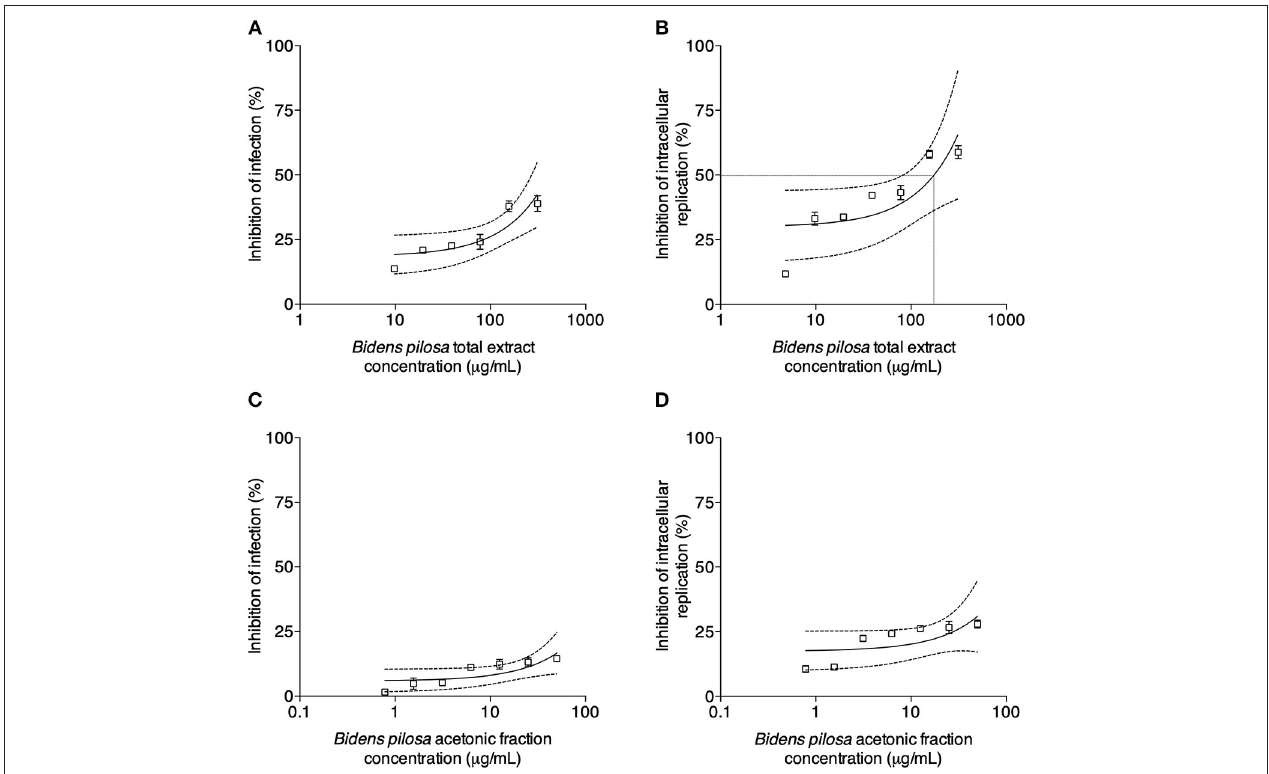
FIGURE 6 | Effects of treatment with B. pilosa on HeLa cells infected by T. gondii. Treatments were carried out after T. gondii infection on HeLa cells with total extract (A,B) or acetonic fraction (C,D) of B. pilosa . Results are expressed as inhibition of percentage of infection (A,C) and parasite intracellular replication (B,D) in comparison to controls. Dotted lines show the inhibitory concentration of 50% (IC 50 ) and bars represent standard deviations. Values are representative from three independent experiments, indicating mean ± SD.